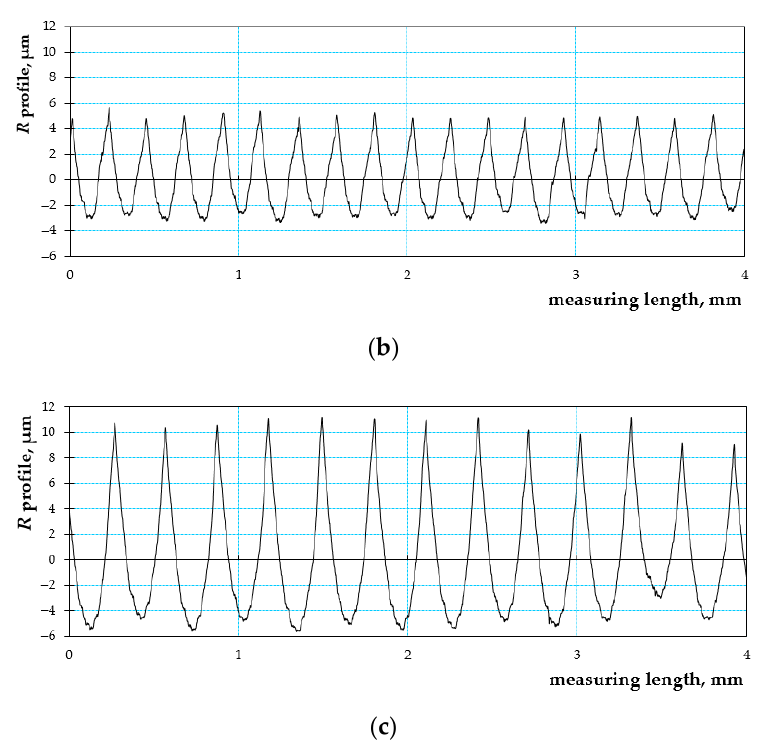
Figure 7. Roughness diagrams for various values of feed: ( a ) f = 0.18mm, ( b ) f = 0.2mm, ( c ) f = 0.3mm ( v = 200 m/min).